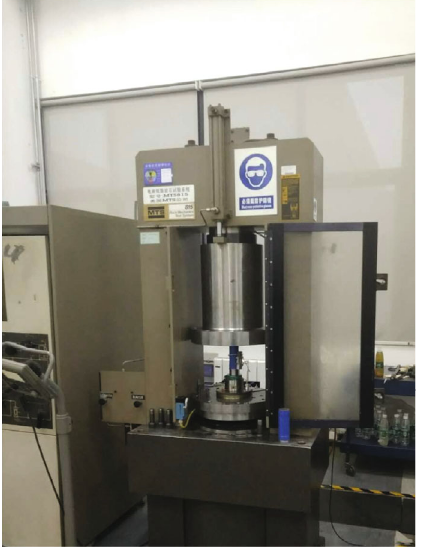
Figure 4: MTS815 test machine.